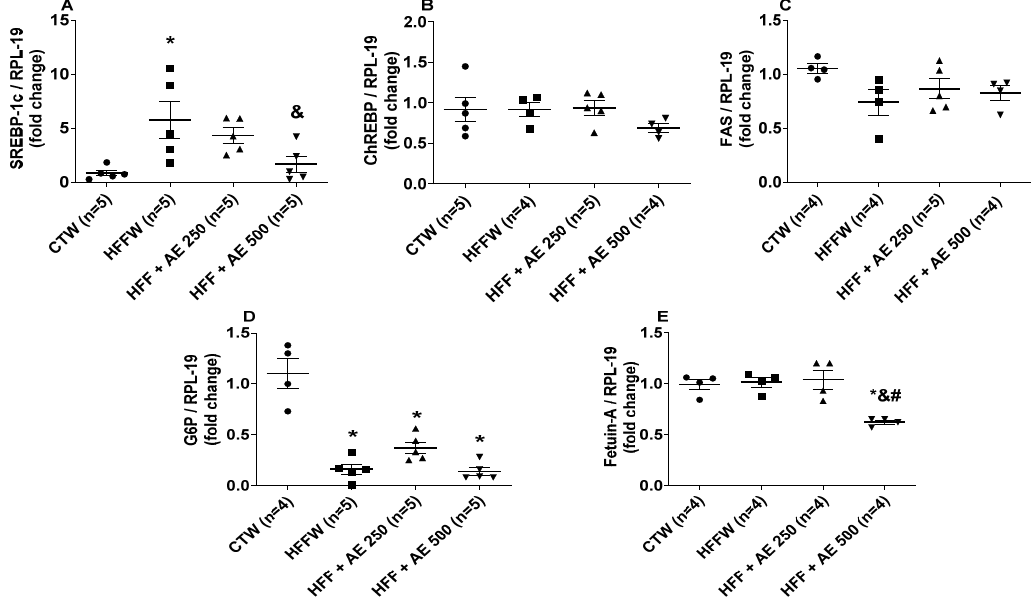
Figure 10. The effects of a high-fat/high-fructose diet and M. citrifolia (noni) aqueous extract (AE) in the expression of metabolic genes in the liver ( A ) sterol regulatory element binding protein-1c (SREBP-1c); ( B ) carbohydrate response element binding protein (ChREBP); ( C ) fatty acid synthase; ( D ) glucose-6-phosphatase (G6P); ( E ) fetuin-A of full black circle: CTW (CT + drinking water), full black quadrilateral: HFFW (high-fat/high-fructose diet + drinking water); black up-pointing triangle: HFF + AE 250 (HFF + M. citrifolia fruit aqueous extract of 250 mg/kg); and black down-pointing triangle: HFF + AE 500 (HFF + M. citrifolia fruit aqueous extract of 500 mg/kg) groups. The results are expressed as the mean ± SEM. * = p ≤ 0.05 vs. CTW; & = p ≤ 0.05 vs. HFFW; # = p ≤ 0.05 vs. HFF + AE 250. ANOVA, followed by the Tukey post-test.